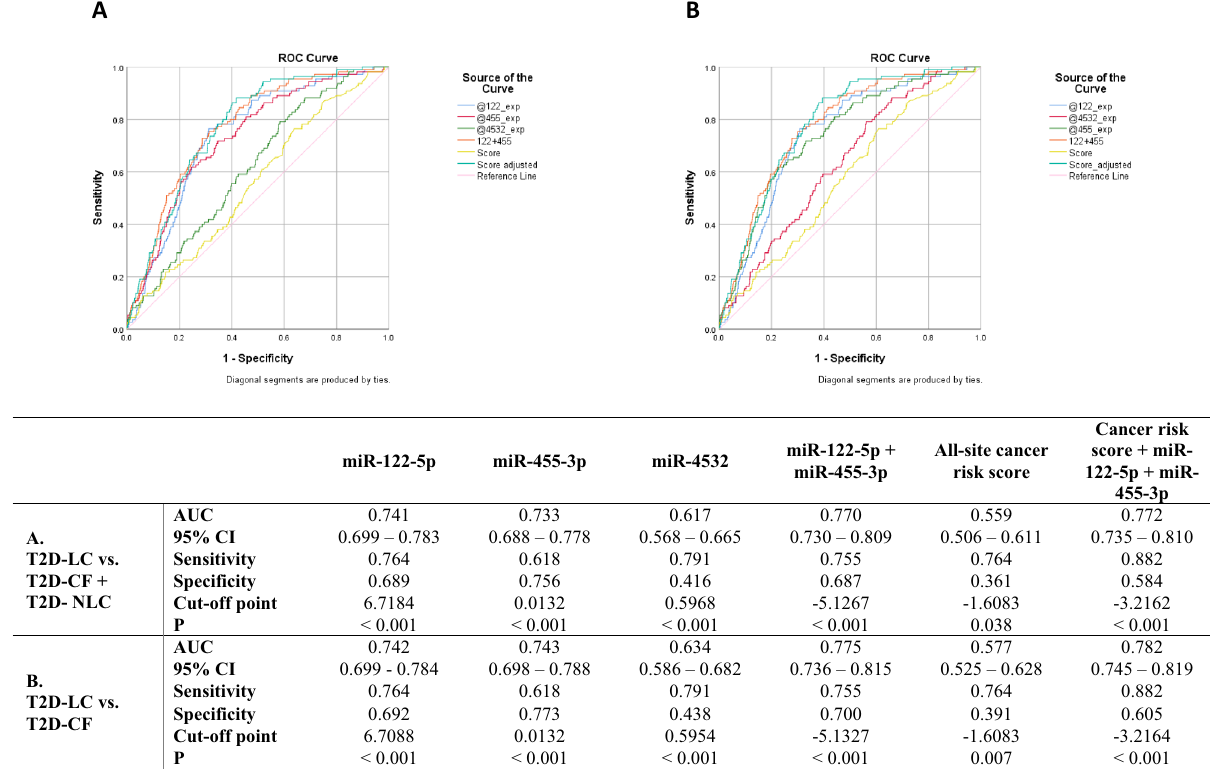
Figure 5. Receiver operating characteristic (ROC) analysis of serum microRNA (miRNA) level in type 2 diabetes (T2D) with liver cancer cases versus T2D without cancer cases and T2D non-liver cancer cases. The miR-186-5p normalized serum levels of miR-122-5p (@122_exp), miR-455-3p (@455_exp) and miR-4532 (@4532_exp) were analysed using SPSS v.25. The sum of Log values serum level of miR-122-5p and miR-455-3p (122 + 455) and the all-site cancer risk score and the sum of 122 + 455 and all-site cancer risk score (Score adjusted) were included for comparison. The serum levels of T2D liver cancer group were tested against the T2D cancer-free group and T2D with other cancer group combined ( A ) and the T2D cancer-free group only ( B ). The diagonal reference line was shown for comparison. The summaries of area under the curve (AUC) with 95% confidence intervals (95% CI), optimal sensitivity and specificity and P values were shown below.